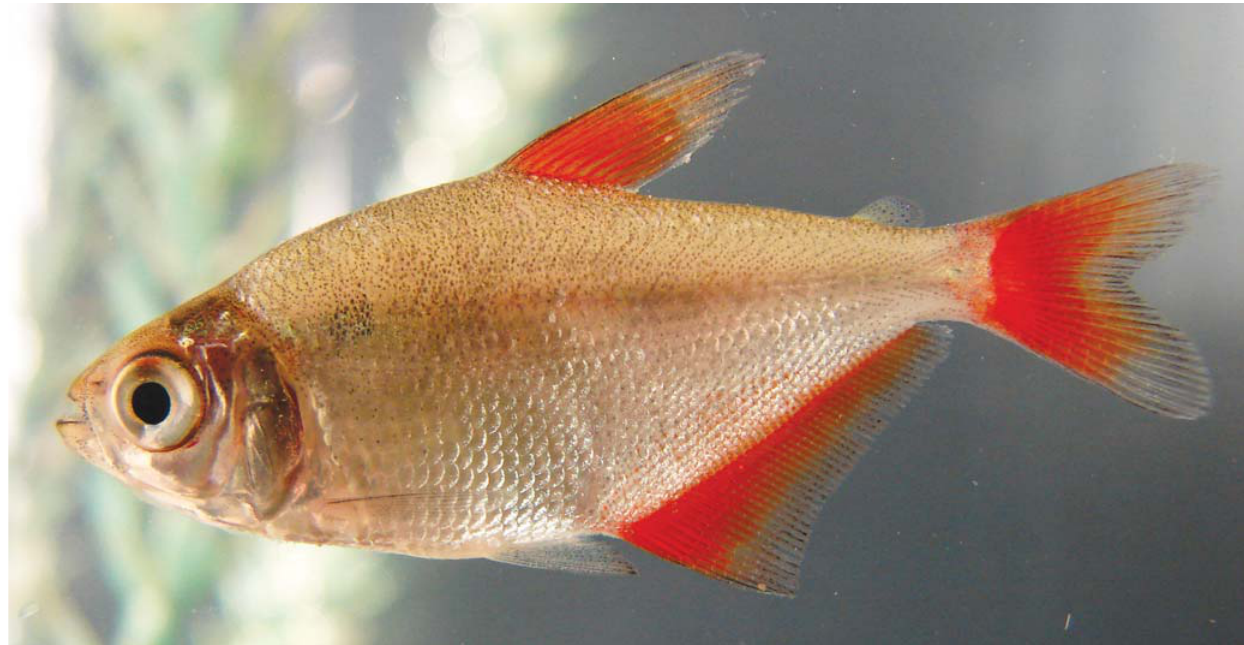
Fig. 1. Astyanax erythropterus (juvenile), MACN-ict 9453, 29.9 mm SL, Argentina, Provincia de Entre Ríos, Parque Nacional Pre-Delta, río Paraná basin. Photographed in